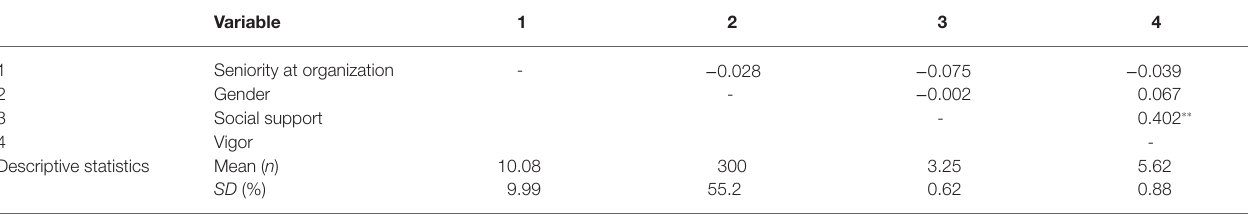
TABLE 1 | Pearson correlations and descriptive statistics for all variables. Variable